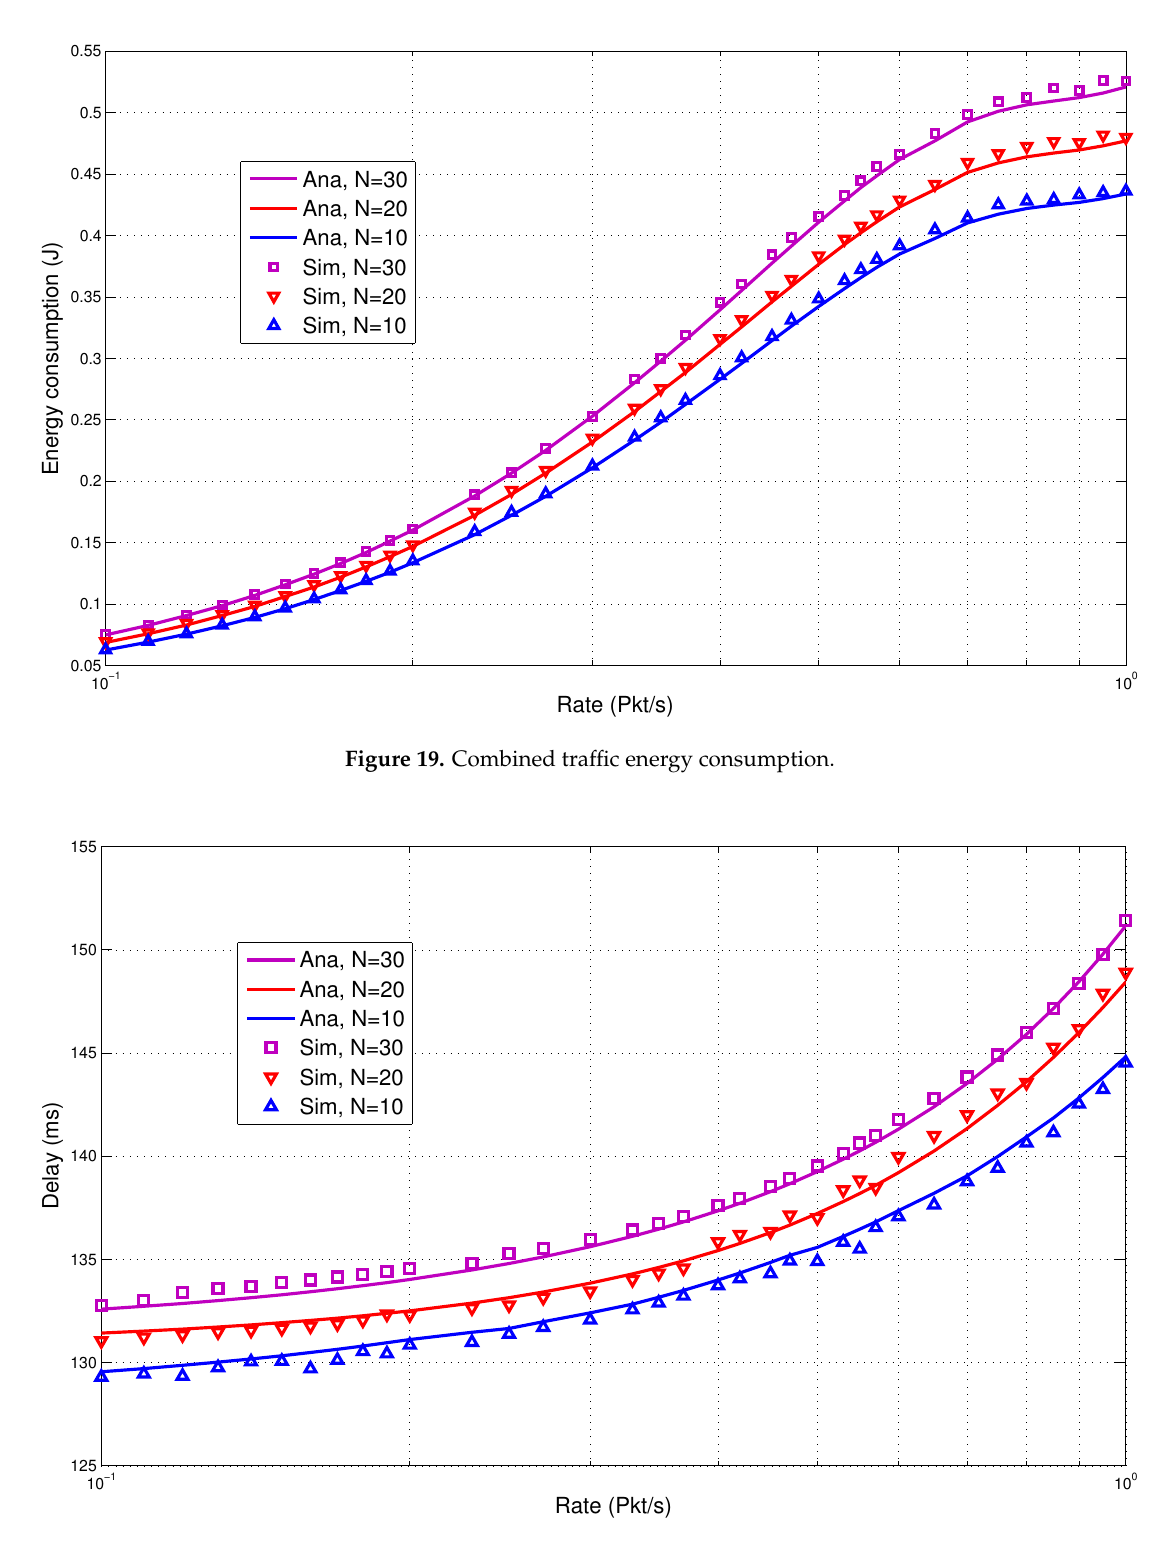
Figure 20. Combined traffic